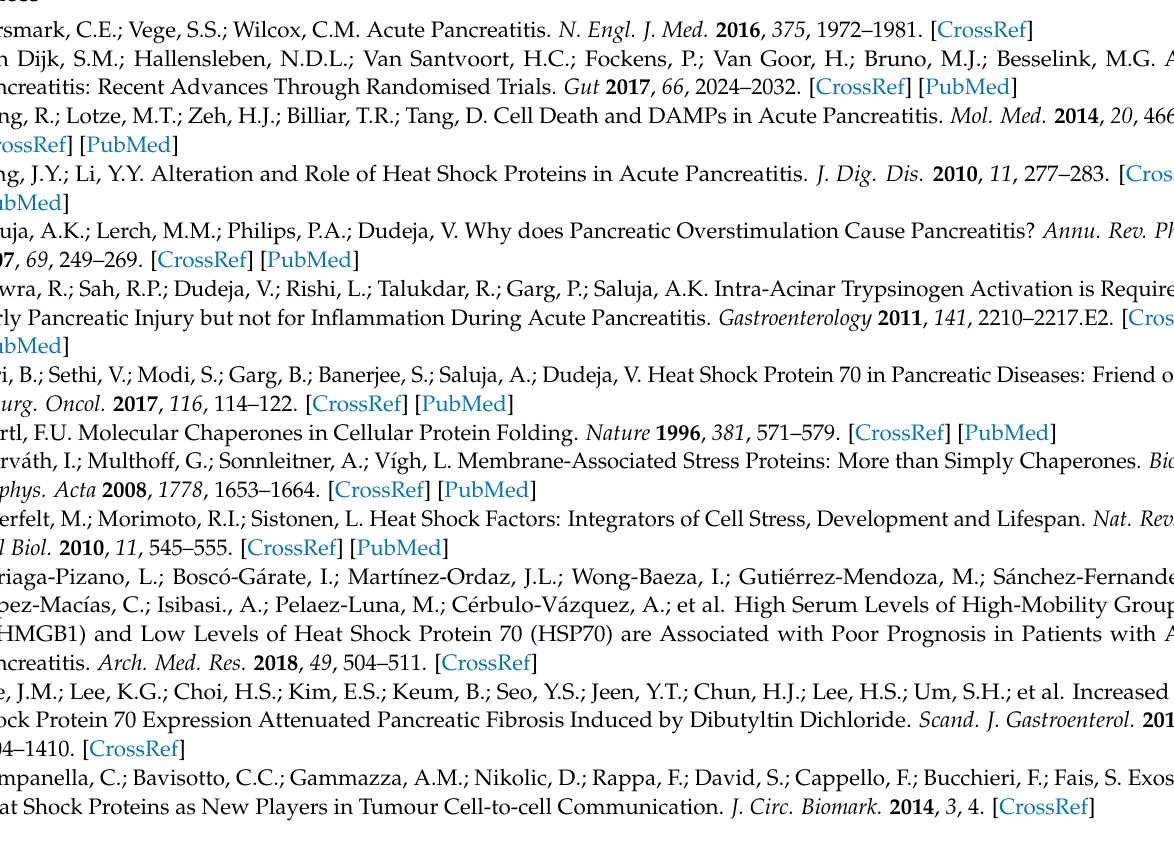
Table S3, The calculated conductance and capacitance of tBLM as a function of HSP70 concentration in urine and buffer in range from 25 nM to 0.2 µ